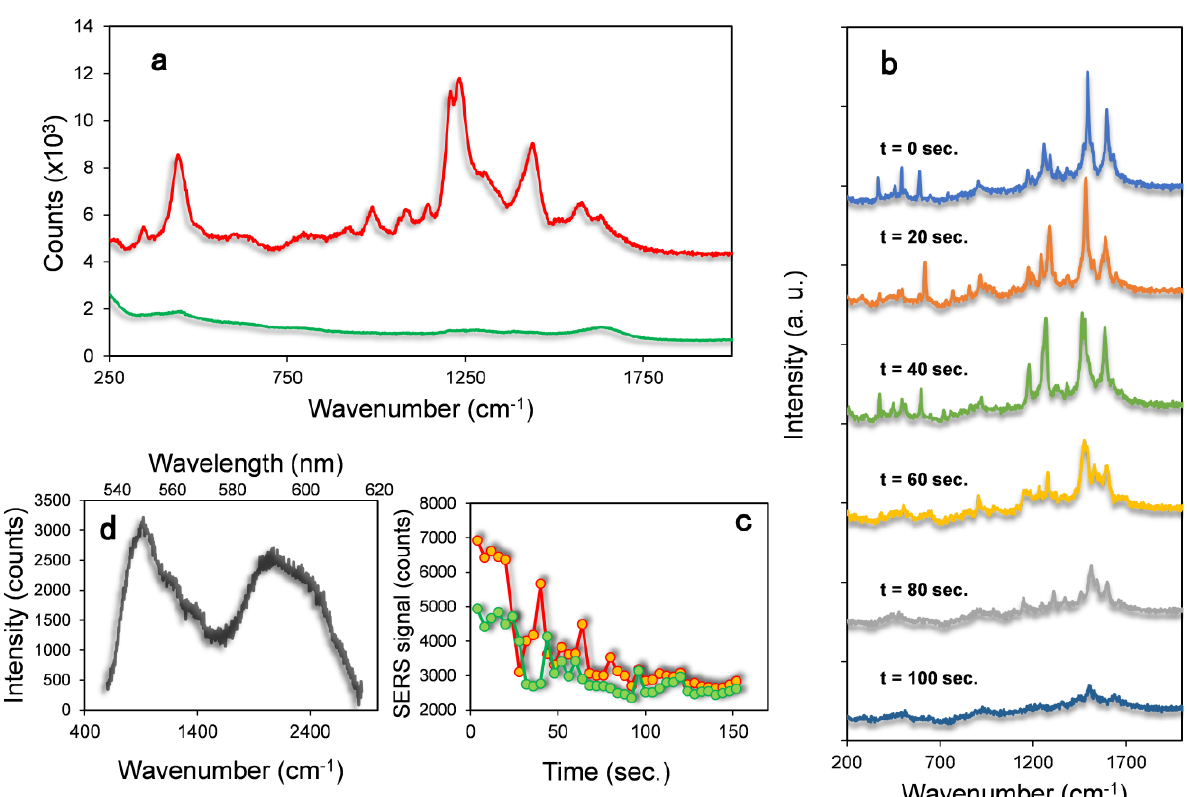
Figure 3. ( a ) Raman spectroscopy of the AuNS-Dox-PEG sample (red line) and Doxorubicin solution (green line) using 633 nm laser excitation in water. ( b ) Raman spectra of living cells incubated with AuNS-Dox-PEG acquired at different time intervals under continuous irradiation from top (t = 0 s) to bottom (t = 100 s). ( c ) Plot of the integrated area of the 1500 cm − 1 (red dots) and 1600 cm − 1 (green dots) Raman peaks corresponding to the quinine ring and C=C bond vibrations of Dox molecules. ( d ) Doxorubicin Fluorescence emission of the hotspot acquired after the Raman measurements .